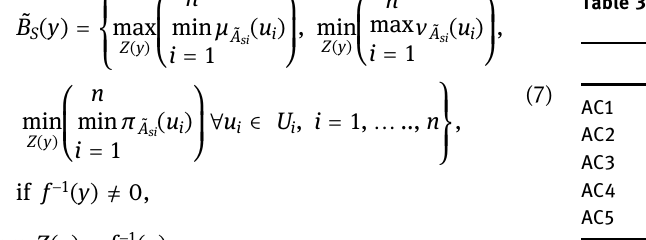
Table 3: Pairwise comparison table